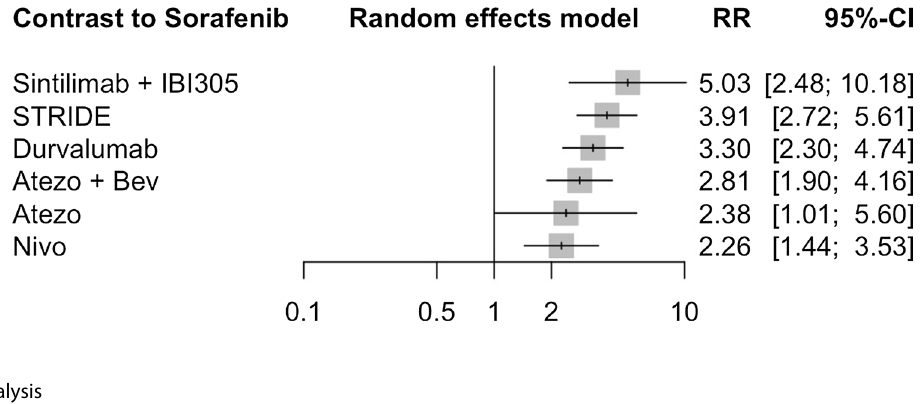
Fig. 9 Forest plot for ORR compared to sorafenib